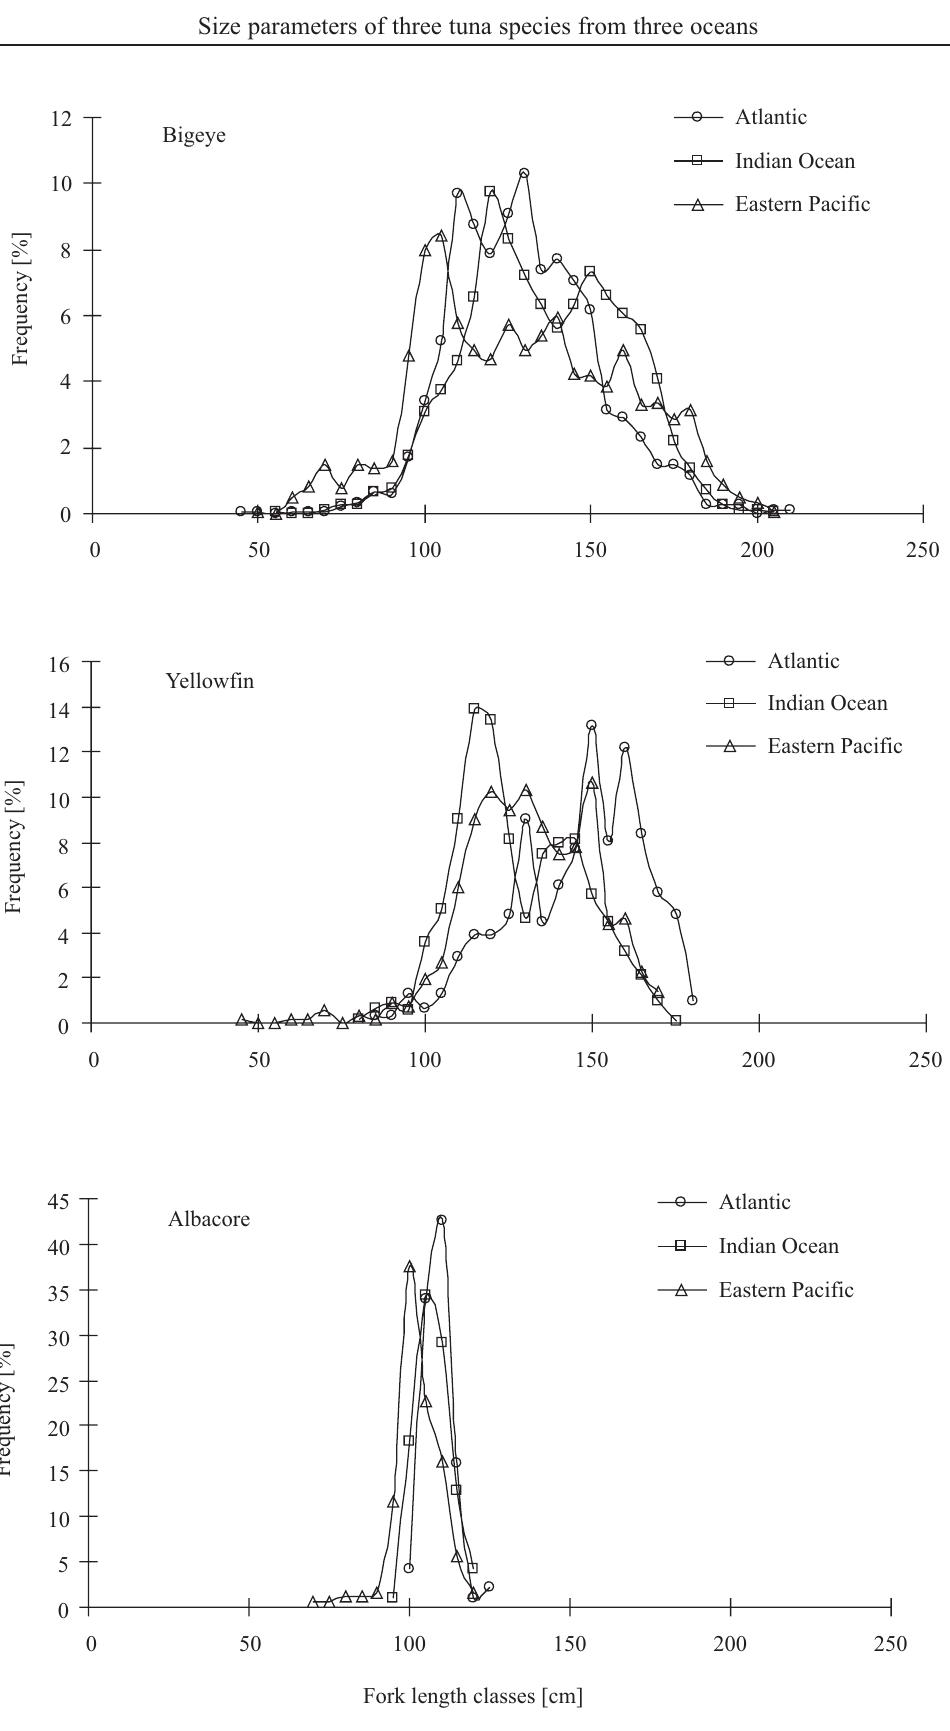
Fig. 2. The fork length distributions of bigeye tuna, yellowfin tuna, and albacore collected from the Atlantic, Indian, and eastern Pacific